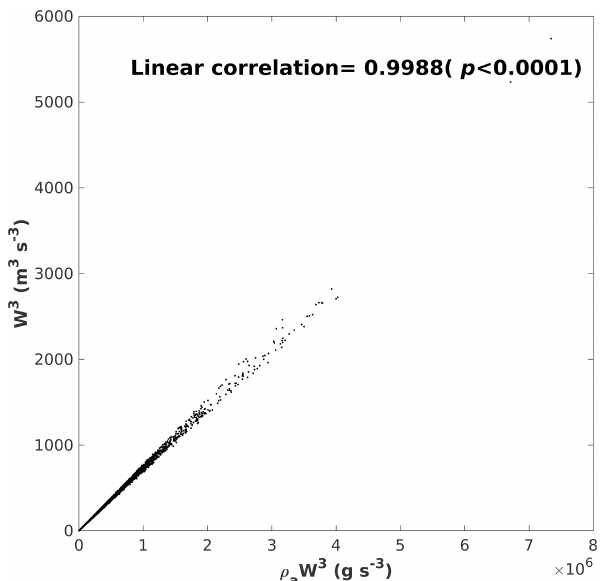
Figure A2. A scatterplot of ρ a W 3 against W 3 and their linear correlation.